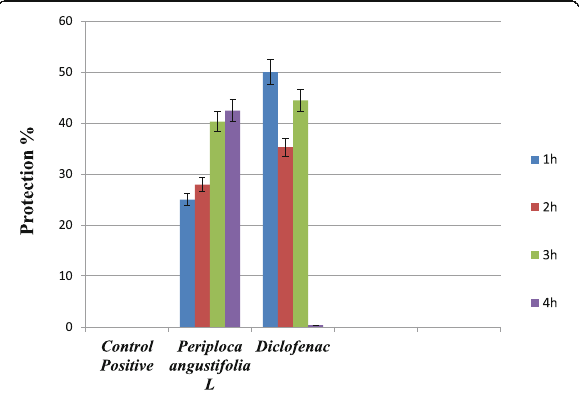
Fig. 3 Anti-inflammatory activity of Periploca angustifolia L.